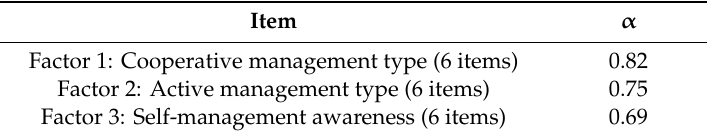
Table 3. Sexual risk-coping consciousness: factor analysis results ( n =